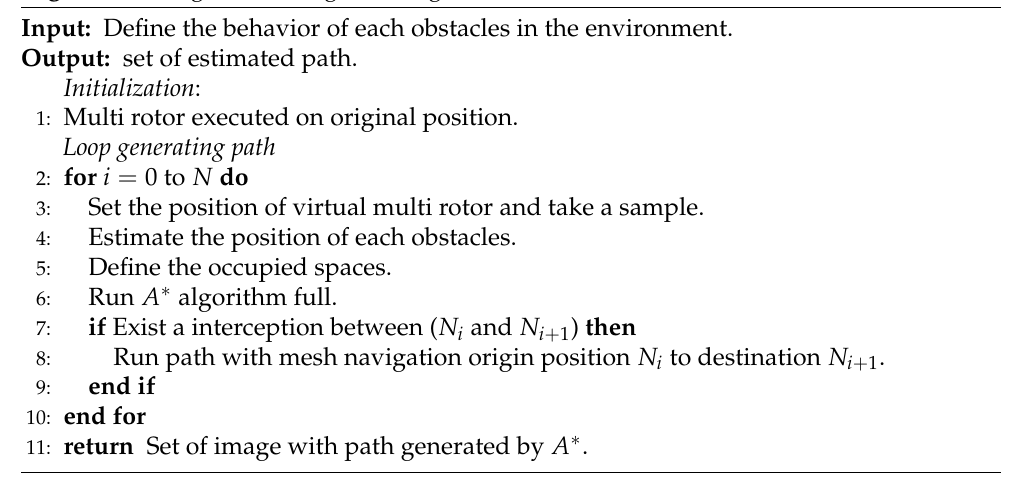
Algorithm 2 Algorithm for generating